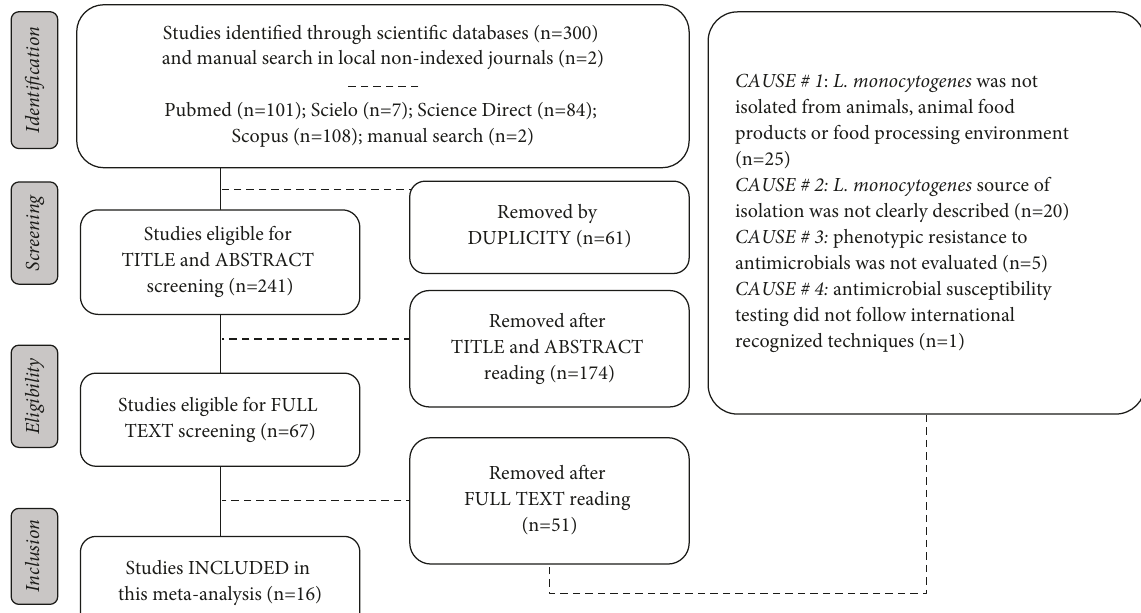
Figure 1: Flowchart of the systematic review procedure. Studies excluded by CAUSE # 1 [2–4, 6, 7, 51–55, 58–71]. Studies excluded by CAUSE # 2 [33, 34, 10–27]. Studies excluded by CAUSE # 3 [28–32]. Studies excluded by CAUSE # 4